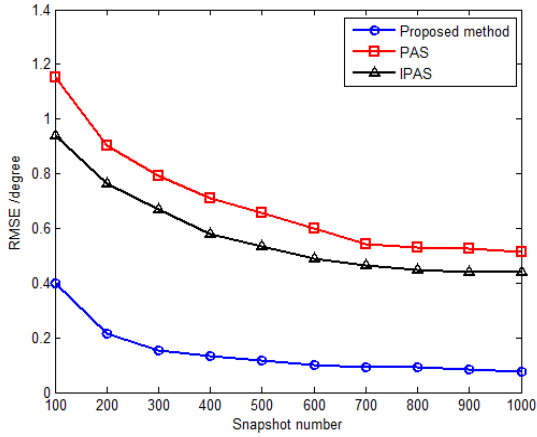
Figure 7. RMSE versus SNR for coherent sources with fixed snapshot number 500.